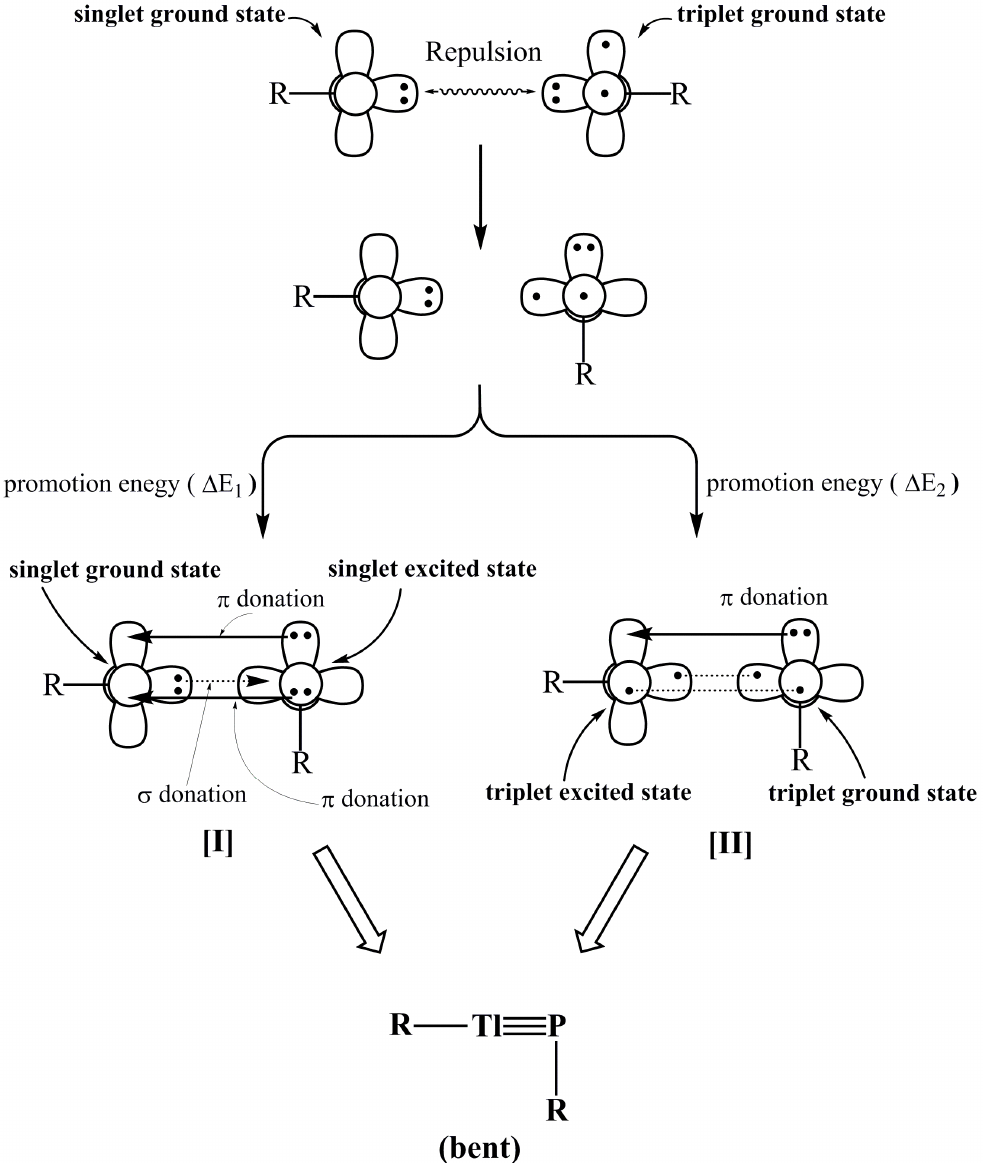
Figure 1. The interaction models, [I] and [II], for the triply bonded RTl ≡ PR molecule.